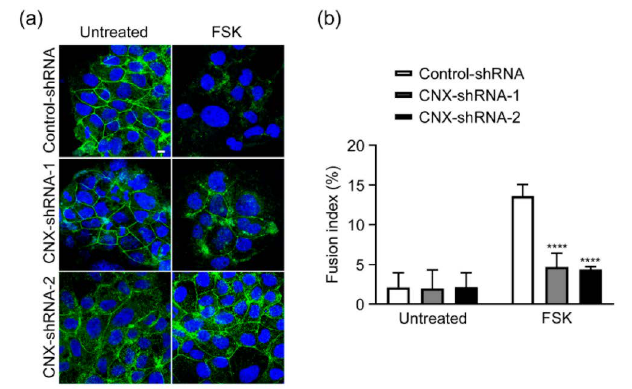
Figure 2. CNX knockdown reduced FSK-induced cell fusion in BeWo cells. ( a ) Control-shRNA cells and CNX-knockdown cells (CNX-shRNA-1 and CNX-shRNA-2) were treated with FSK (50 µ M) for 72 h and were then stained with an anti-ZO-1 antibody. Nuclei were stained with DAPI. Scale bar: 20 µ m. ( b ) Control-shRNA cells and CNX-knockdown cells (CNX-shRNA-1 and CNX-shRNA-2) were treated with FSK (50 µ M) or DMSO (0.05%) for 72 h, after which cell fusion was evaluated and quantified via the fusion index, as described in Materials and Methods. Data are shown as means ± SD of three independent experiments. **** p < 0.0001 vs. Control-shRNA